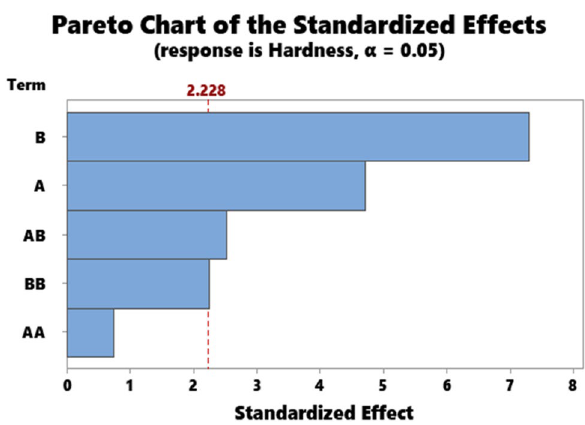
Figure 7. Pareto chart for hardness.